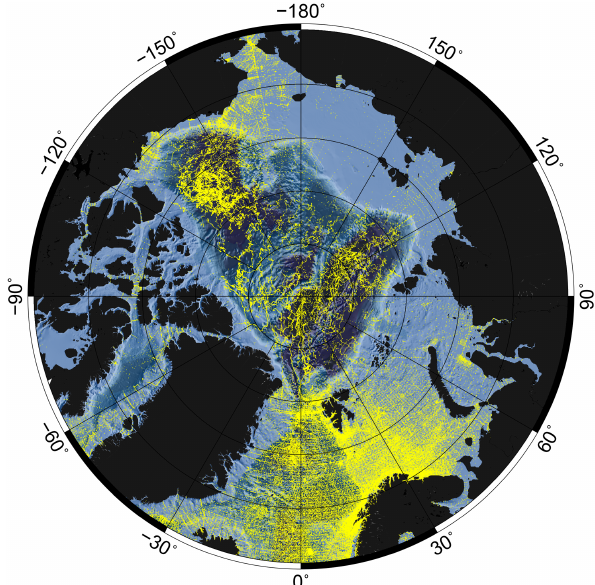
Figure 1. Data coverage after quality check and data